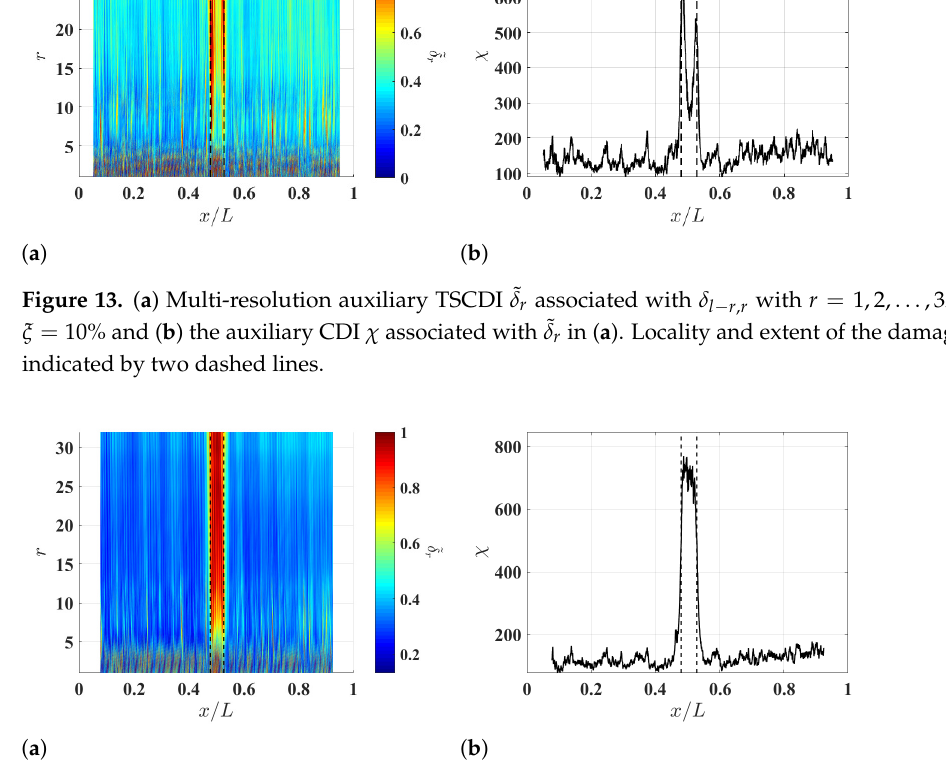
Figure 14. ( a ) Multi-resolution auxiliary TSCDI ˜ δ r associated with δ l − r , r with r = 1,2, . . . ,32 and ξ = 15% and ( b ) the auxiliary CDI χ associated with ˜ δ r in ( a ). Locality and extent of the damage are indicated by two dashed